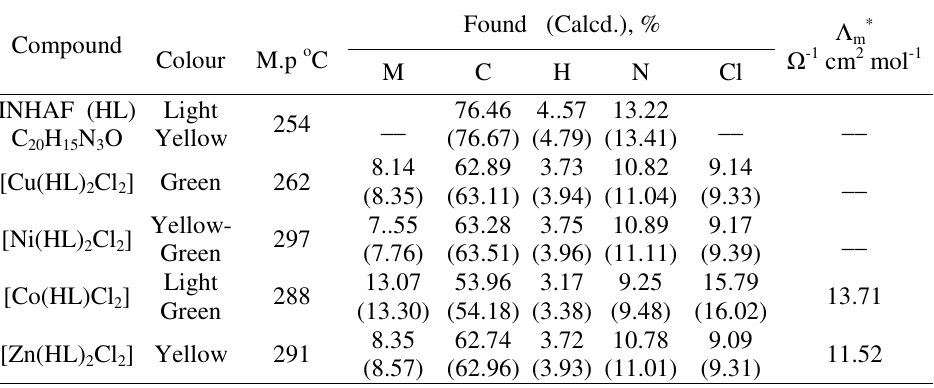
Table 1. Analytical and physical data of the complexes.